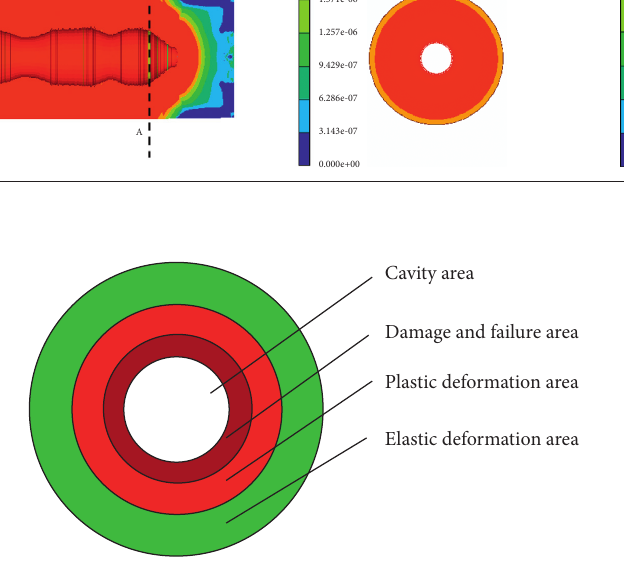
Figure 12: Schematic diagram of strain area distribution in gelatin target. Table 5: Penetration results of different micro-jets on gelatin